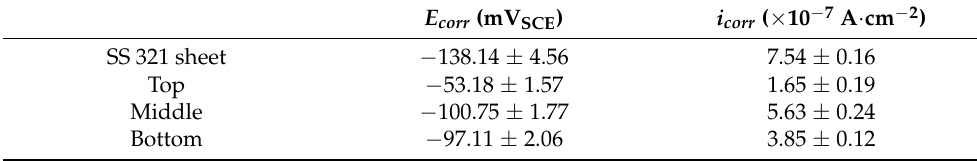
Figure 8. Surface morphologies of corroded SS 321 sheet ( a ), and samples ( b ), ( c ), and ( d ) extracted from the top, middle, and bottom regions of the SS 321, respectively. Table 2. Parameters extracted from potentiodynamic polarization curves (Figure